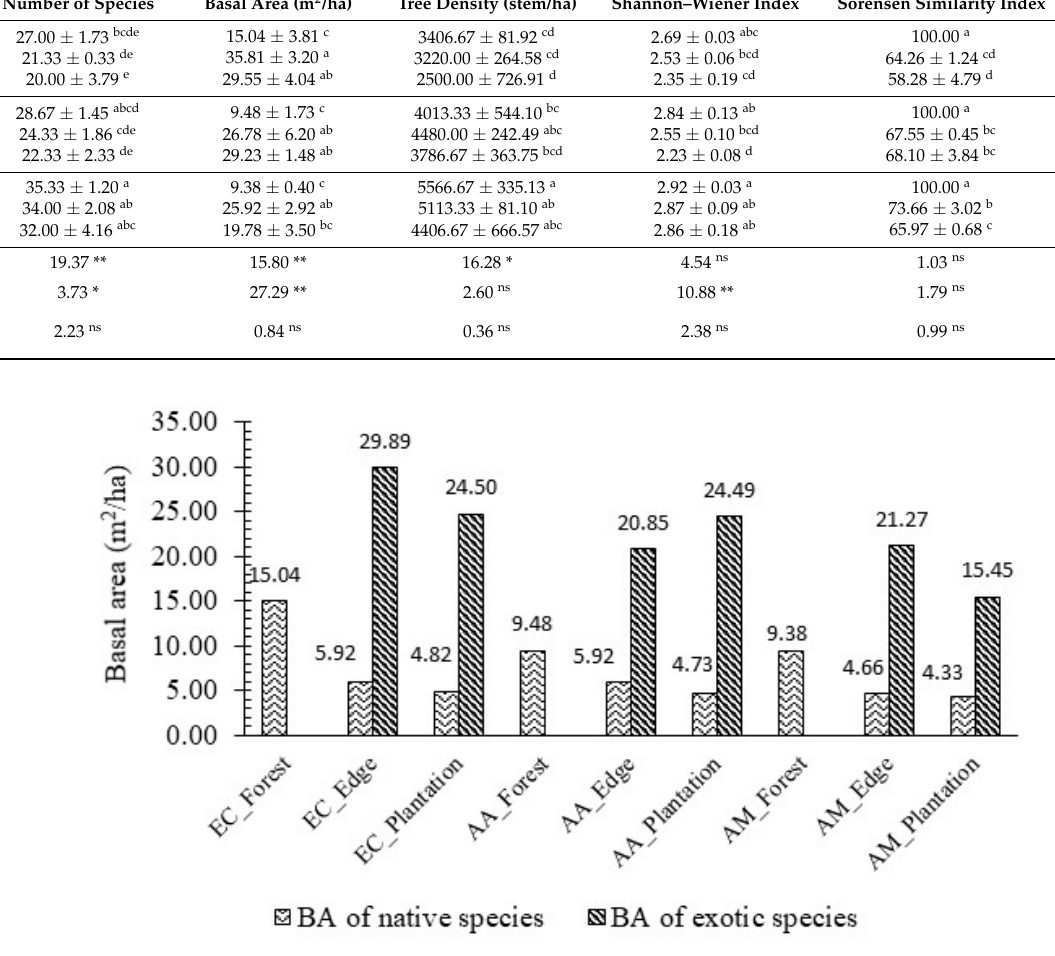
Figure 3. Basal area of native and exotic species in nine stands of three exotic plantations. EC: Eucalyptus camaldulensis , AA: Acacia auriculiformis , AM: A. mangium . Tree regeneration for native species based on DBH class distribution in all plantations exhibited L-shaped negative exponential growth (Figure 4). In all stands, the frequency of small trees was higher, while the frequency of large trees decreased with increasing